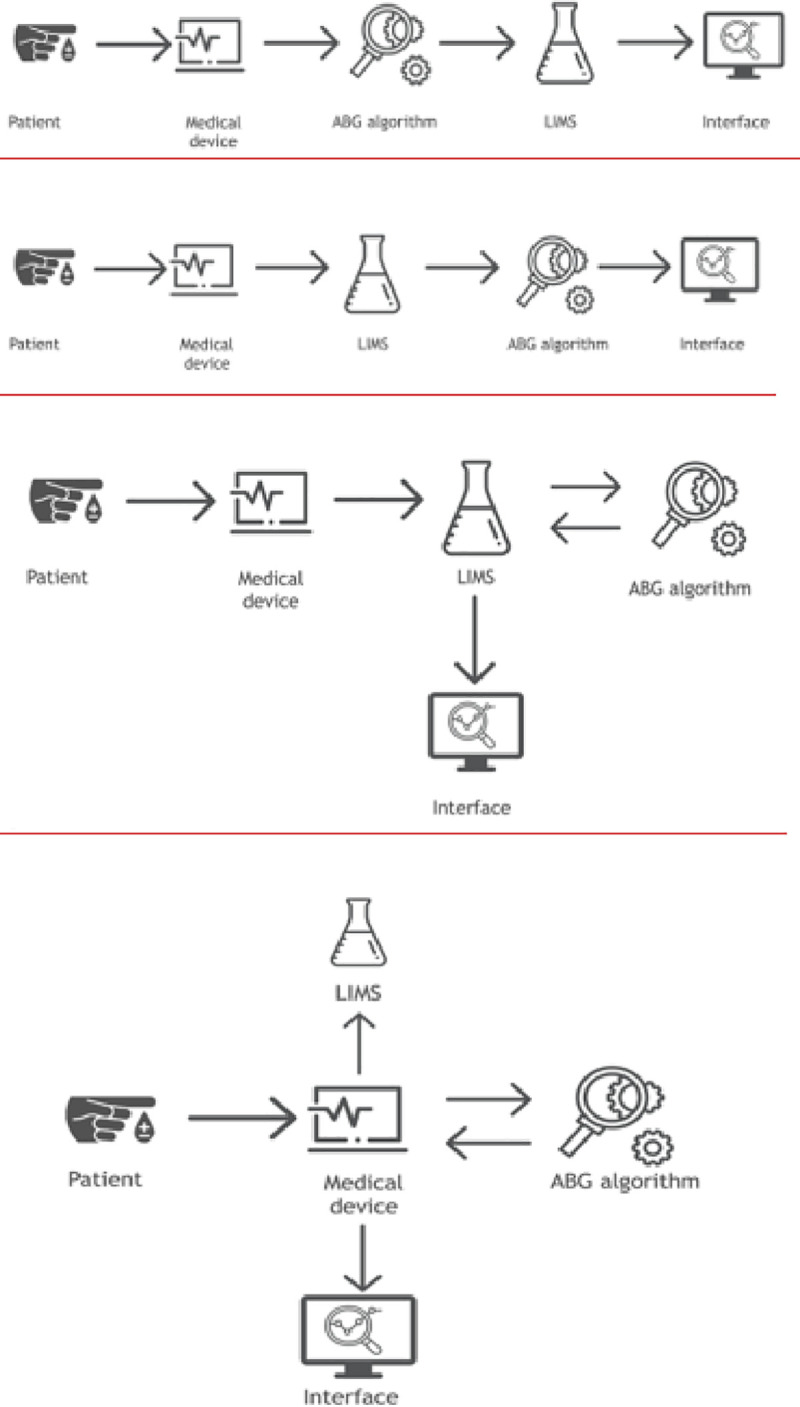
Connectivity.Data can be fed into the ABG-a manually for example, into small devices or used in countries where the digital hospital data has not yet been fully developed. It can also be embedded directly into medical devices, such as an arterial blood gas machine (including portable blood gas analysers), extracorporeal support machines, a monitor, database or any other biochemistry/haematology programs available through an interface for the communication and integration of the results with HIS and other devices.